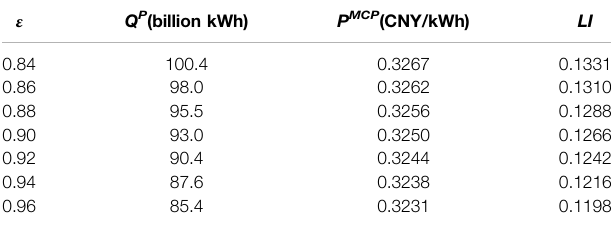
TABLE 3 | Market-clearing results under different risk aversion degrees of